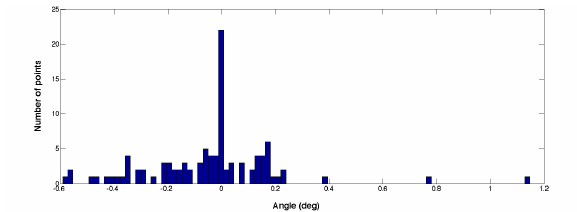
Figure 13: Histogram obtained for the θ calculation related to Figure 11a